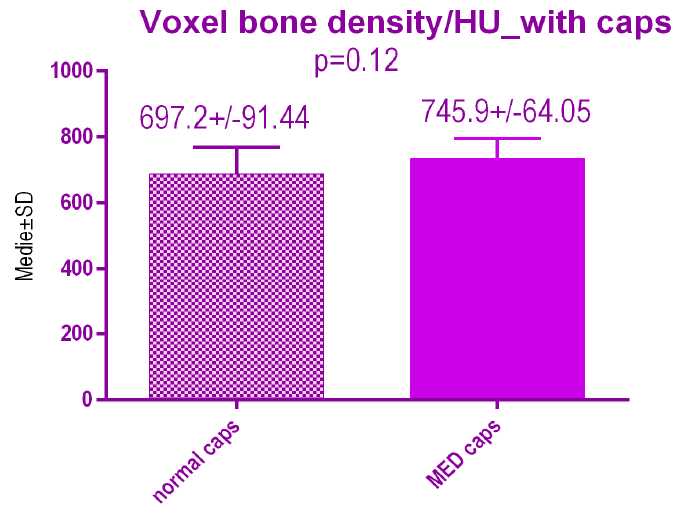
Figure 19. Bone radiodensity in the study groups after treatment.